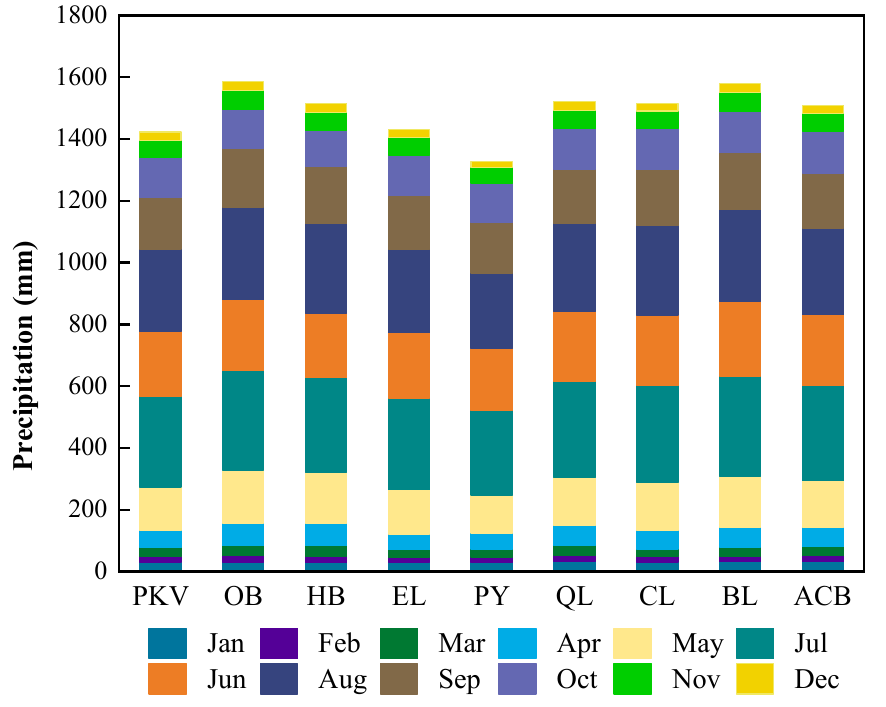
Figure 12. Average monthly precipitation statistics of different tree species in the study area.